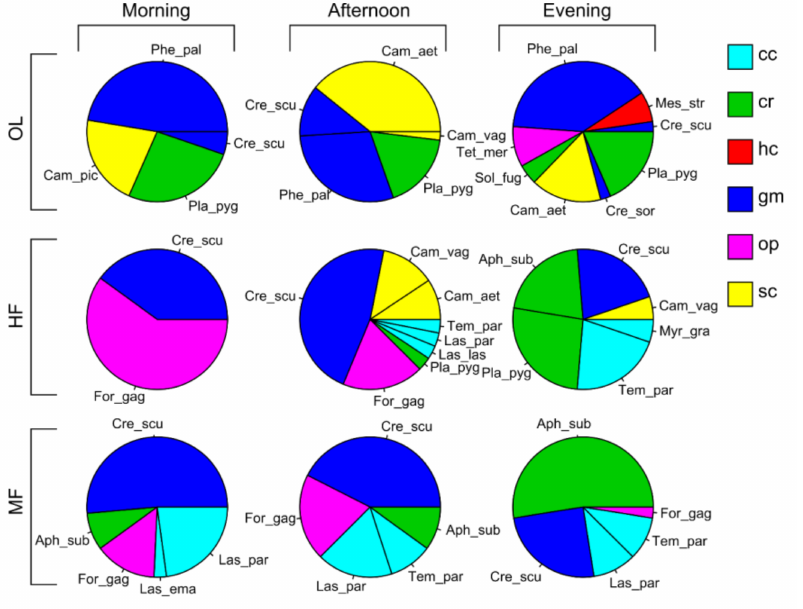
Figure 3. Pie charts of the proportion of incidence of species on the total (i.e., the sum of the incidence of each species in the two transects in that habitat and in that period) in the three habitats and for the three daily periods. Different colors represent functional groups: cc, cold-climate specialist; cr, cryptic species; hc, hot-climate specialist; gm, generalized Myrmicinae, op, opportunist; sc, subordinate Camponotini. Species abbreviations: Aph_sub, Aphenogaster subterranea ; Cam_aet, Camponotus aethiops ; Cam_pic, Camponotus piceus ; Cam_vag, Camponotus vagus ; Cre_scu, Crematogaster scutellaris ; Cre_sor, Crematogaster sordidula ; For_gag, Formica gagates ; Phe_pal, Pheidole pallidula ; Las_las, Lasius lasioides ; Las_par, Lasius paralienus ; Myr_gra, Myrmecina graminicola ; Pla_pyg, Plagiolepis pygmaea ; Sol_fug, Solenopsis fugax ; Tem_par, Temnothorax parvulus : Tet_mer, Tetramorium meridionalis